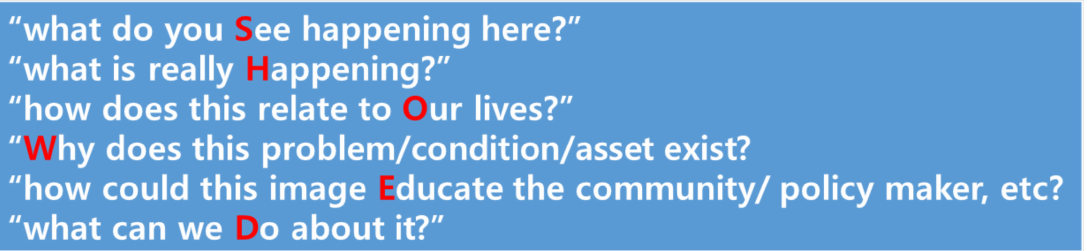
Figure 2. Detail of the SHOWeD